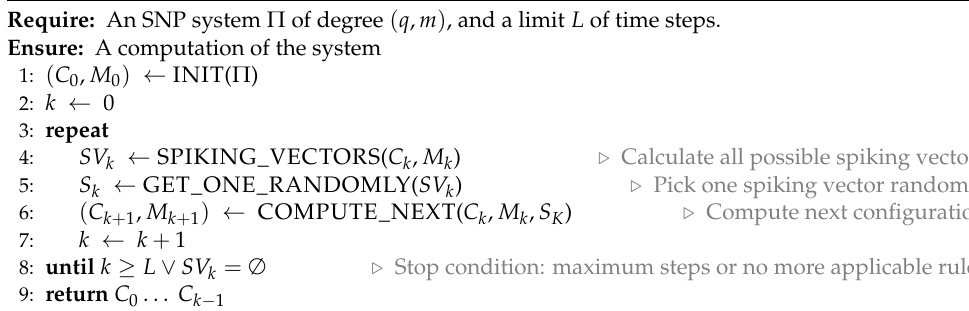
Algorithm 2 MAIN PROCEDURE: simulating one computation for spiking neural P sys-